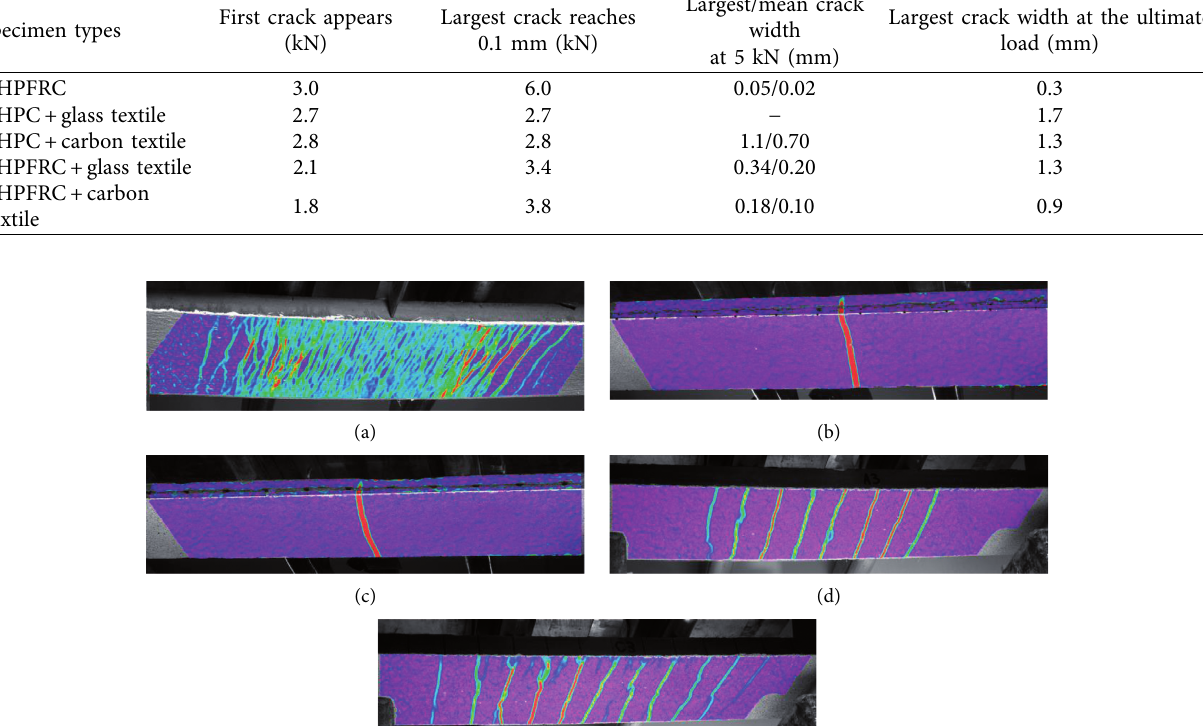
Table 6: Key values from the crack evaluation.